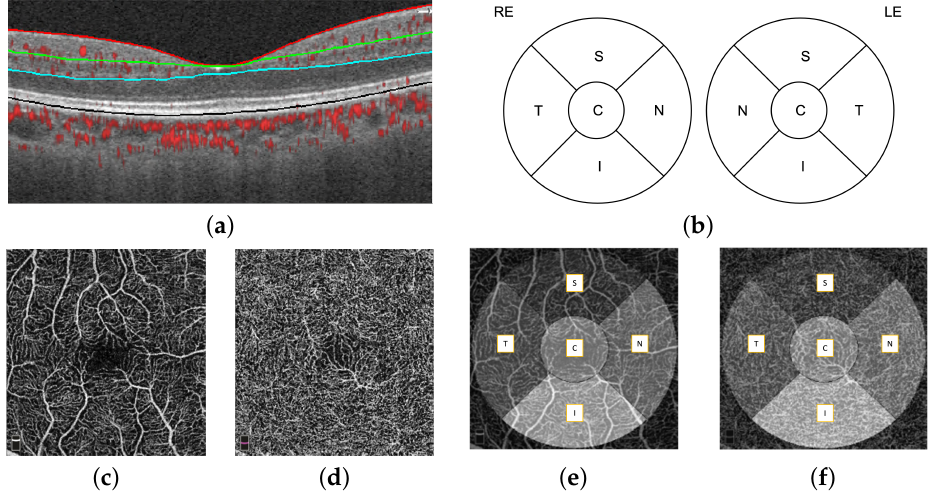
Figure 2. A 3 × 3 mm fovea-centered OCT-A image, ( a ) A horizontal OCT-A scan showing segmented retinal layers, ( b ) ETDRS circles for the right (RE) and left (LE) eye, ( c , e ) the en face image of the superficial layer (ILM to IPL) overlaid with the ETDRS grid, and ( d , f ) the en face image of the deep layer (IPL to OPL) overlaid with the ETDRS